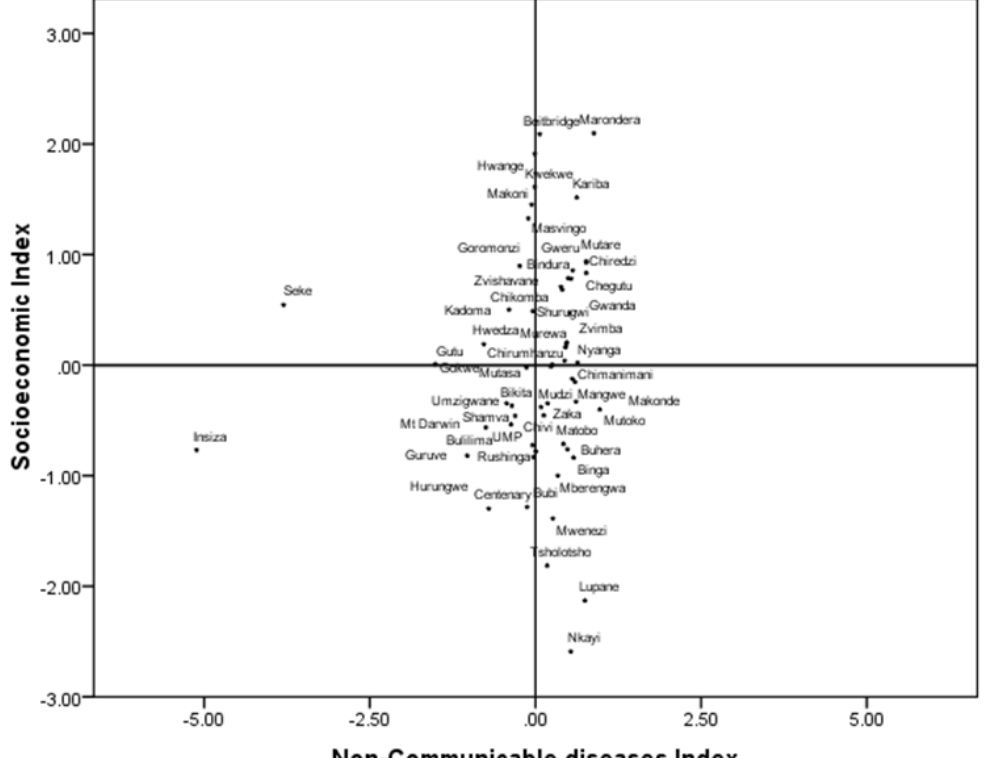
Figure 4. Scatterplot of Socioeconomic Status Index and Non-Communicable Diseases